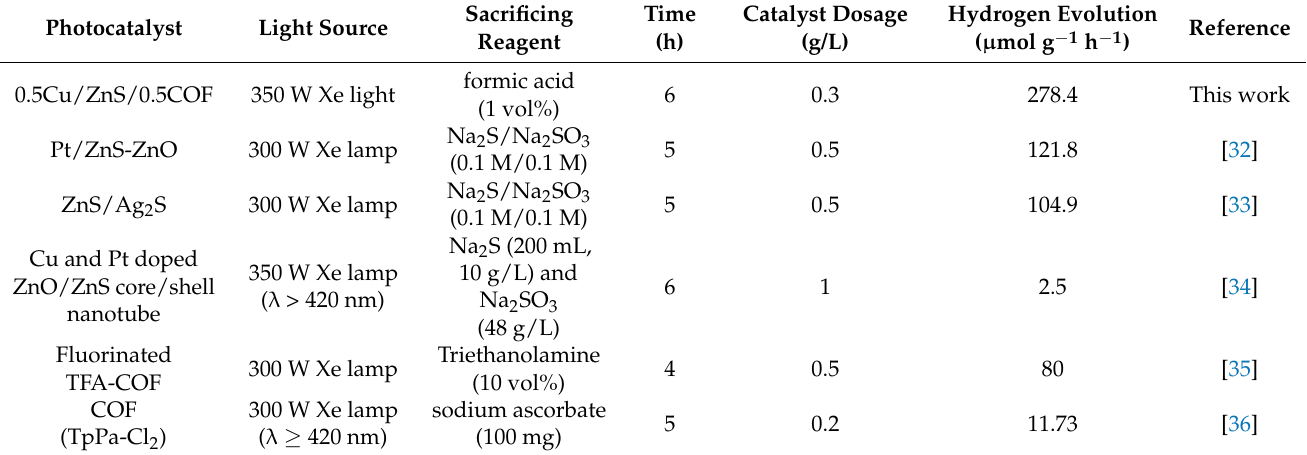
Table 2. Comparison of hydrogen production rates of different ZnS-based photocatalysts and COF photocatalysts.